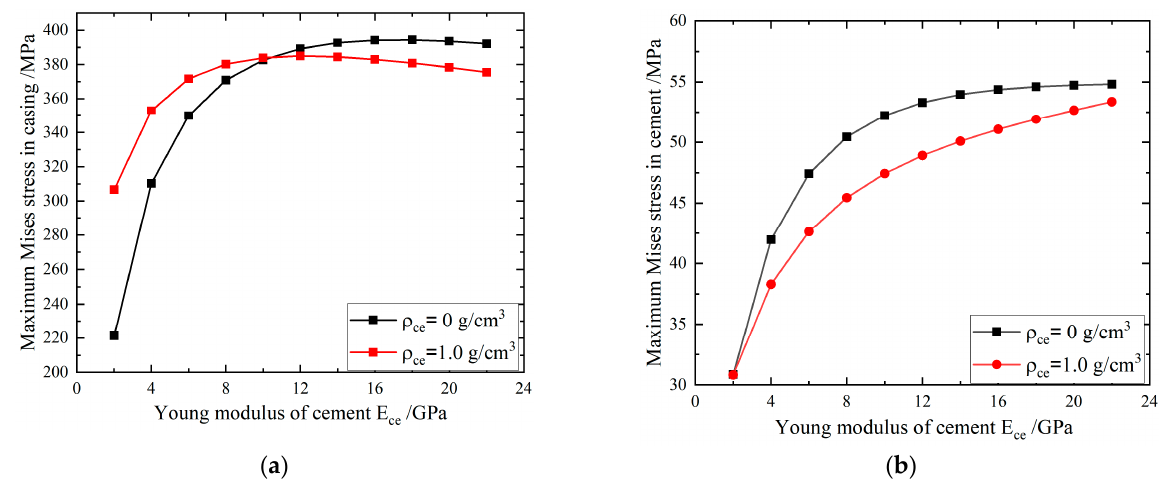
Figure 11. The e ff ect of Young’s modulus and initial stress of cement on the maximum von Mises Figure 11. The effect of Young’s modulus and initial stress of cement on the maximum von Mises stress in ( a ) casing and ( b ) cement in the present 3D model. stress in ( a ) casing and ( b ) cement in the present 3D